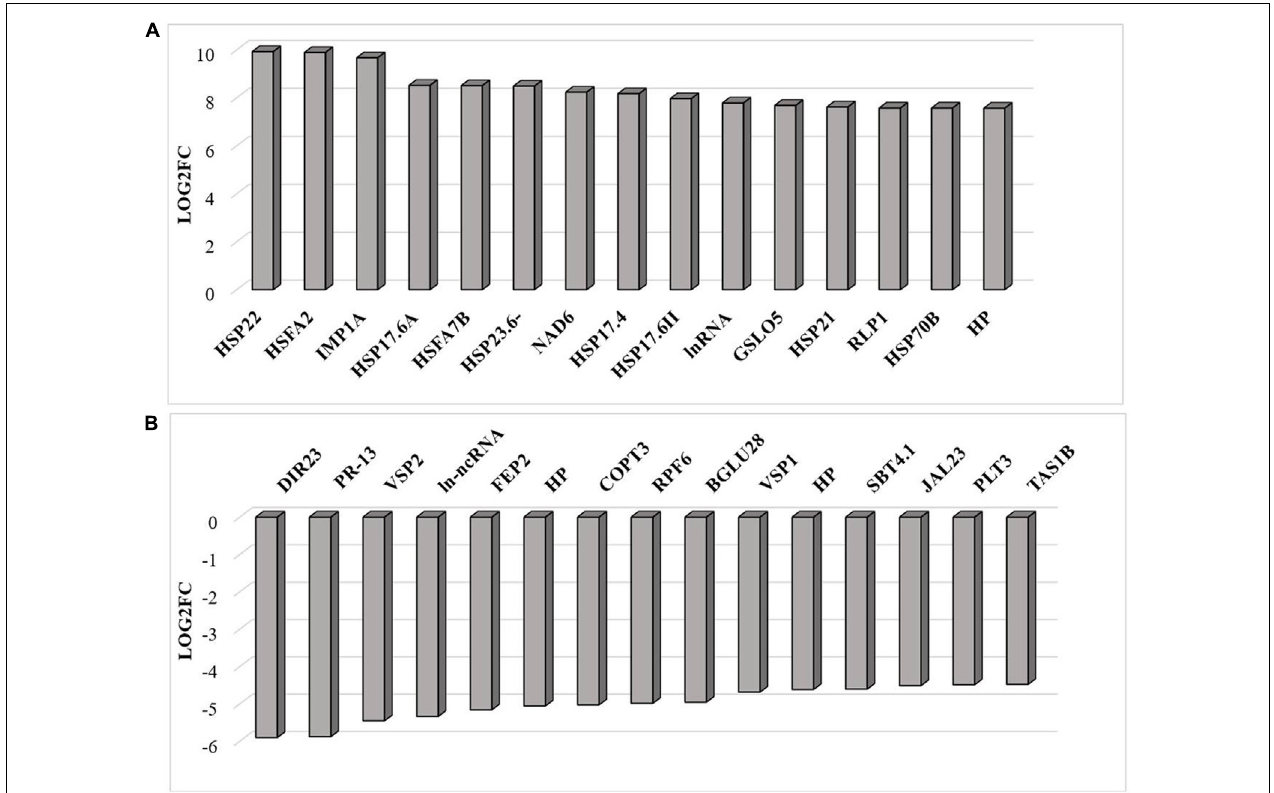
FIGURE 6 | The transcripts that were most differentially changed in abundance after heat stress. The relative expression (log2) fold change-range of transcripts was annotated from their gene accession numbers from the TAIR website. Differentially expressed genes were those showing fold changes of (log2FC > 2 for up-regulated genes and log2FC < − 2) for down-regulated genes, an FPKM > 1 and FDR-corrected p- value of 0.05 or less. DIR23 (AT2G2100), PR-13 (AT1G72260), VSP2 (AT5G24770), lncRNA (AT3G12502), FEP2 (AT1G47395), HP-hypothetical protein (AT3G06435), COPT3 (AT3G46900), RPF6 (AT1G63130), BGLU28 (AT2G44460), VSP1 (AT5G24780), HP-hypothetical protein (AT2G19970), SBT4.1 (AT5G59120), JAL23 (AT2G39330), PLT3 (AT2G18480), TAS1B (AT1G50055), HSP22 (AT4G10250), HSFA2 (AT2G26150), HSP17.6C (AT1G53540), HSP17.6A (AT5G12030), HSFA7B (AT3G63350), HSP23.6 (AT4G25200), HSP17.6A (AT5G12030), NAD6 (ATMG00270), HSP17.4A (AT3G46230), HSP17.6 (AT5G12020), natRNA (AT3G07365), CALS12 (AT5G03550), HSP21 (AT4G27670), RLP1 (AT1G07390), HSP17.8 (AT1G16030), HP-hypothetical protein (AT2G07779). (A) Increased in abundance and (B) decreased in abundance.